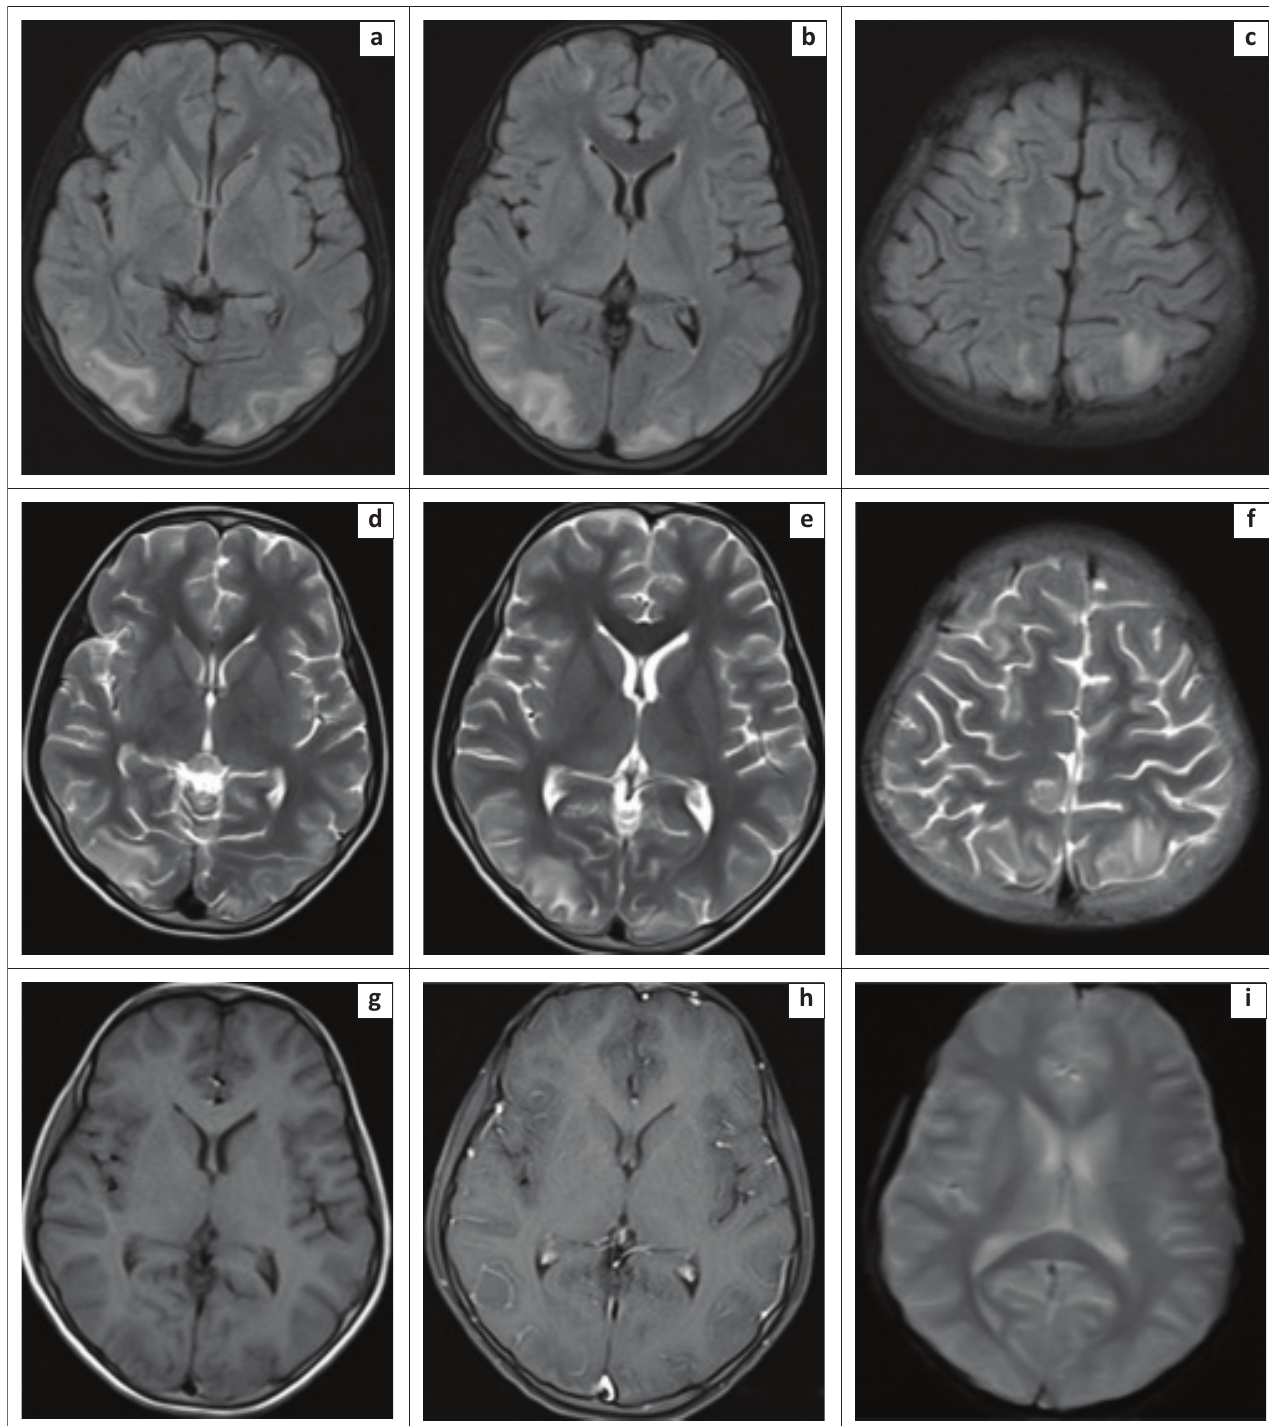
FIGURE 7: [Case 5]: Brain MRI of a 10-year-old female with NS1 antigen seropositive status showing multiple symmetrical patchy areas of FLAIR (a-c) and T2-weighted (d-f) hyperintensities in the bilateral temporo-occipital regions and to a lesser extent in the frontoparietal regions, involving the cortex and subcortical white matter. These areas showed T1 iso to hypointense signal (g) with no post-contrast enhancement (h) and no blooming on GRE images